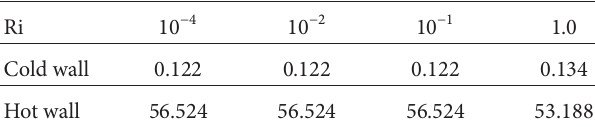
Table 5: Average Nusselt numbers at the hot and cold wall for different Richardson